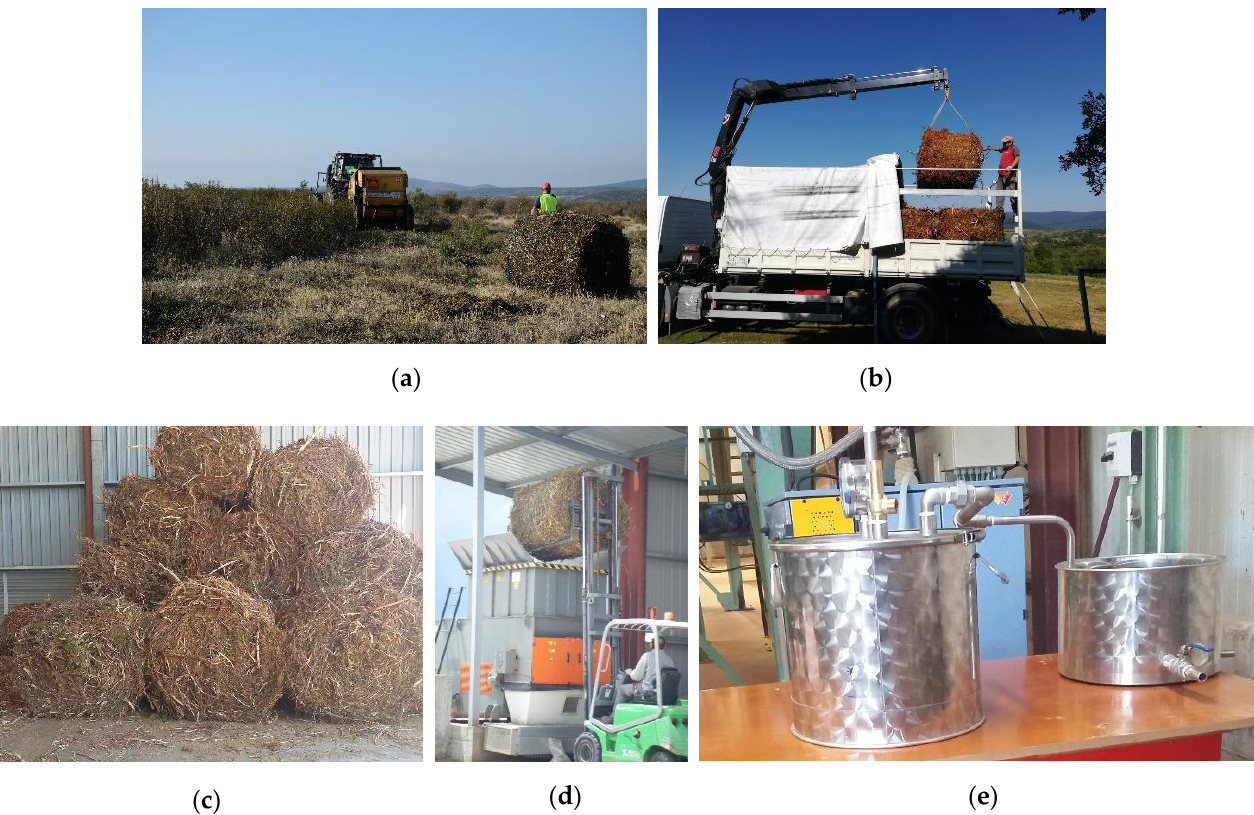
Figure 2. Processes carried out during the pretreatment of the plant material: ( a ) mechanised harvesting of Cistus ladanifer , ( b ) transport of the bales, ( c ) indoor storage, ( d ) crushing of the bales and ( e ) distillation of the milled biomass.